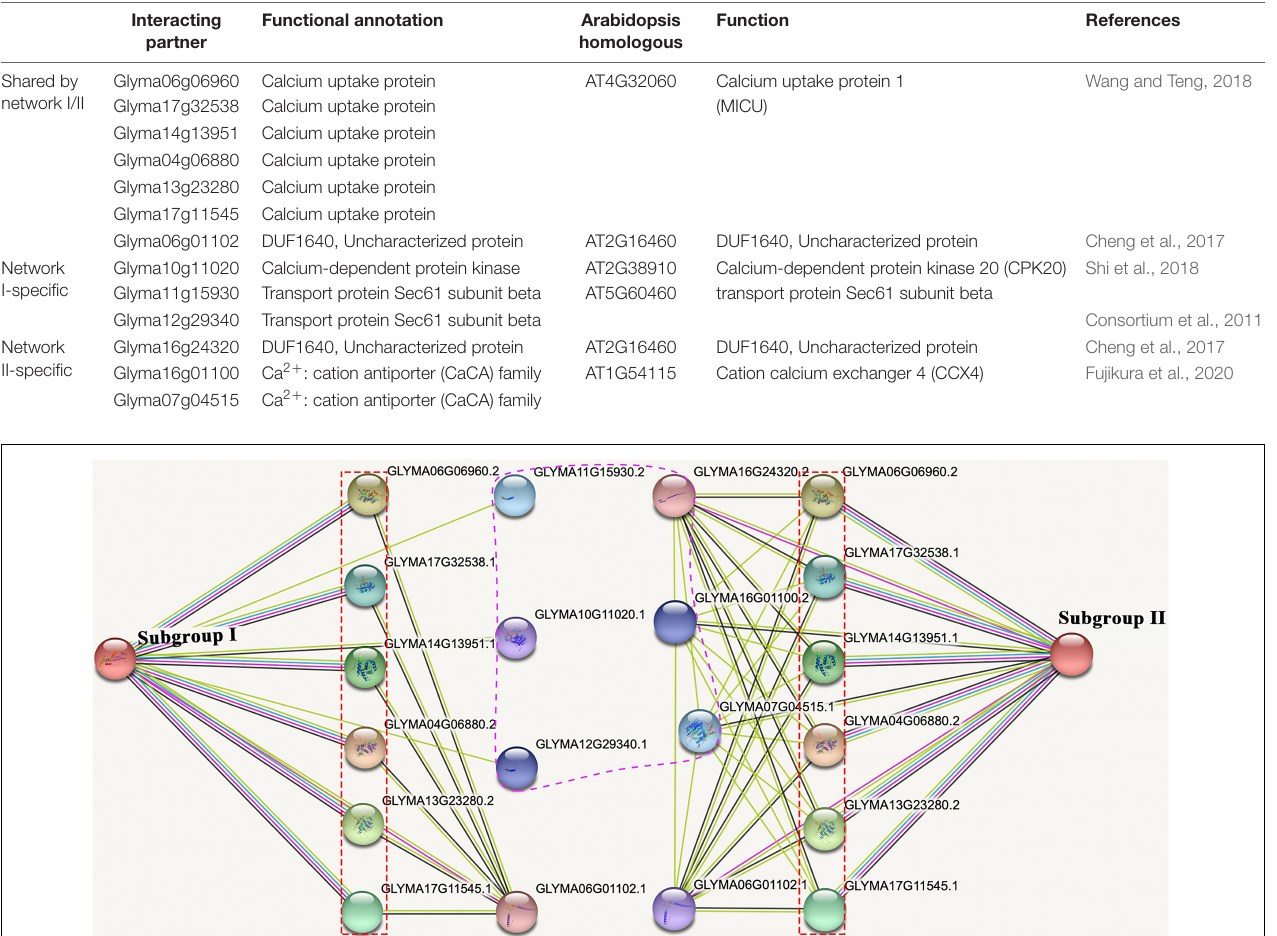
TABLE 3 | Annotation of MCU interacting protein in soybean.